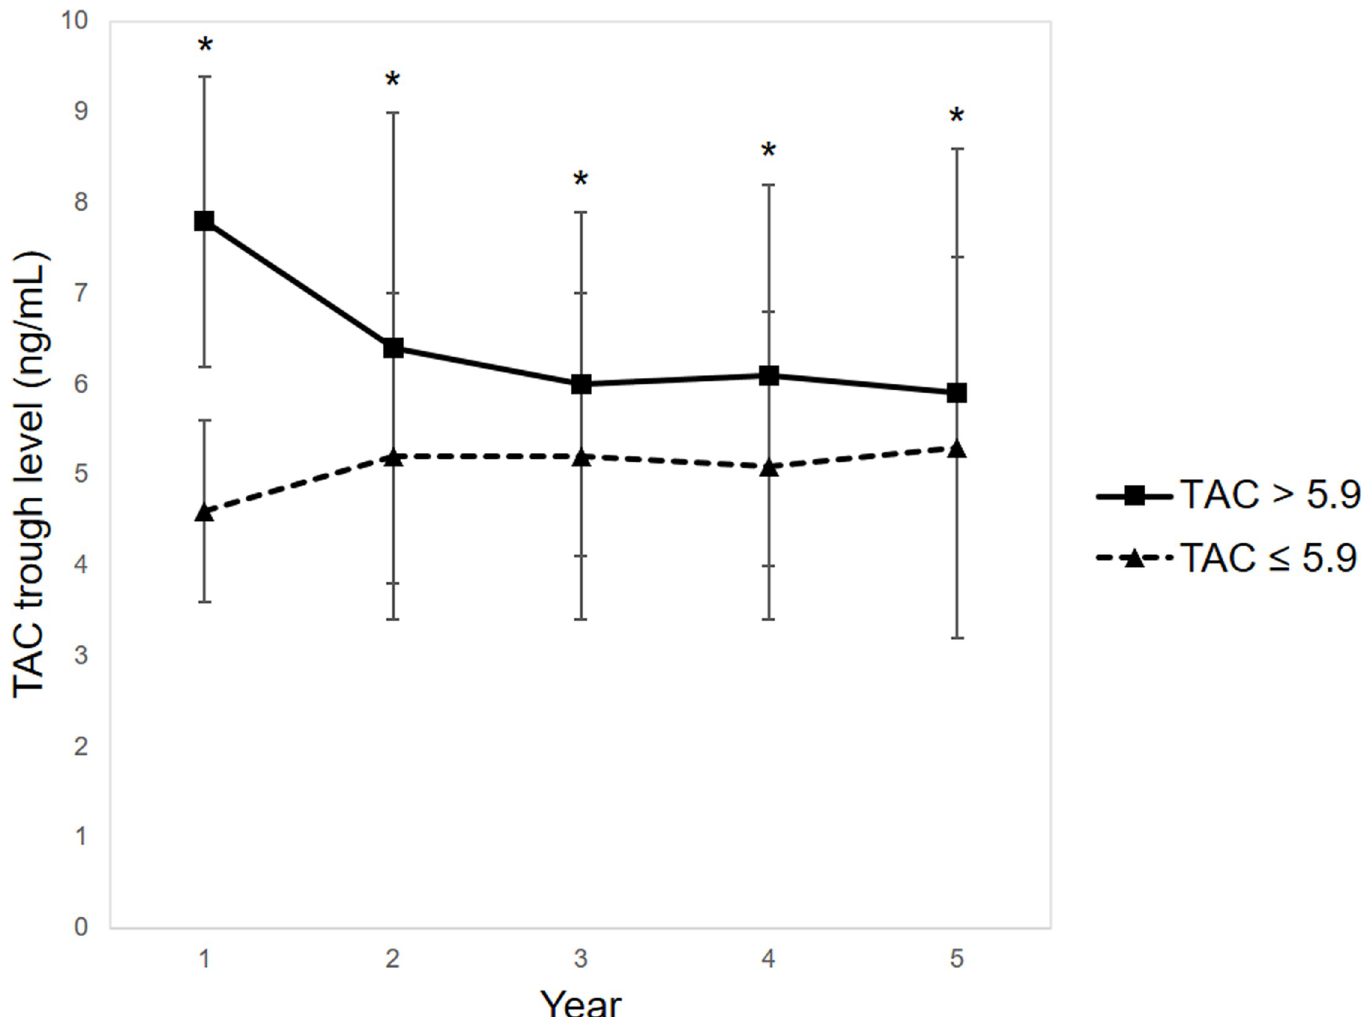
Fig 1. TAC trough levels at 2, 3, 4, and 5 years post-transplant. Patients with HL-TAC at 1 year had significantly higher TAC trough levels at 2 years (6.4 ± 5.2 vs. 5.2 ± 1.8 ng/mL, P < 0.001), 3 years (6.0 ± 1.9 vs. 5.2 ± 1.8 ng/mL, P < 0.001), 4 years (6.1 ± 2.1 vs. 5.1 ± 1.7 ng/mL, P < 0.001), and 5 years (5.9 ± 5.3 vs. 5.3 ± 2.1 ng/mL, P < 0.001) compared with the levels of patients with LL-TAC. � P < 0.001. Abbreviations: LL, low-level; HL, high-level; TAC,